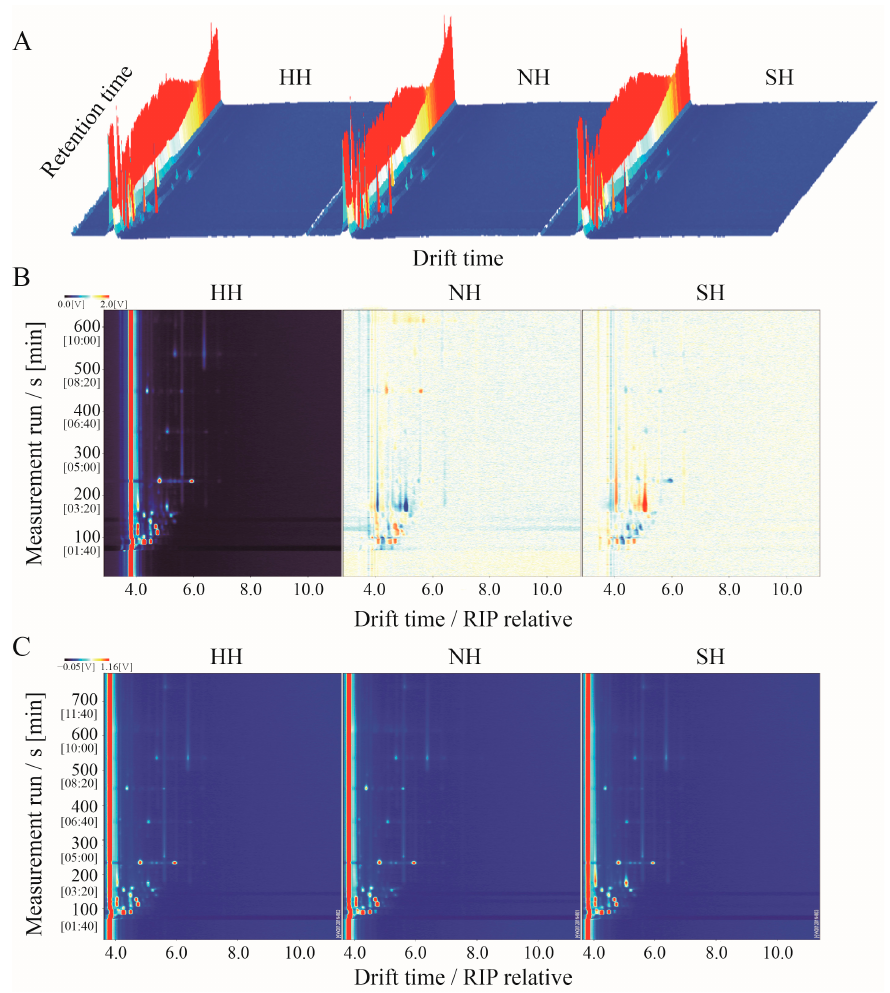
Figure 4. GC-IMS topographic maps in F 1 crossbred lambs. ( A ) GC-IMS 3D spectrum. The x axis—the ion migration time; y axis—the GC retention time; z axis—the peak height of quantification. ( B ) GC-IMS 2D map. HH was regarded as the reference plot. The point colors represent the substance concentration: white—identical concentrations; blue—low concentrations; red—high concentrations. The vertical red line—the reactive ion peak (RIP) normalized to the drift time. Each point represents a volatile compound. ( C ) Ion migration spectra. HH: Hu × Hu, NH: Southdown × Hu, SH: Suffolk × Hu.